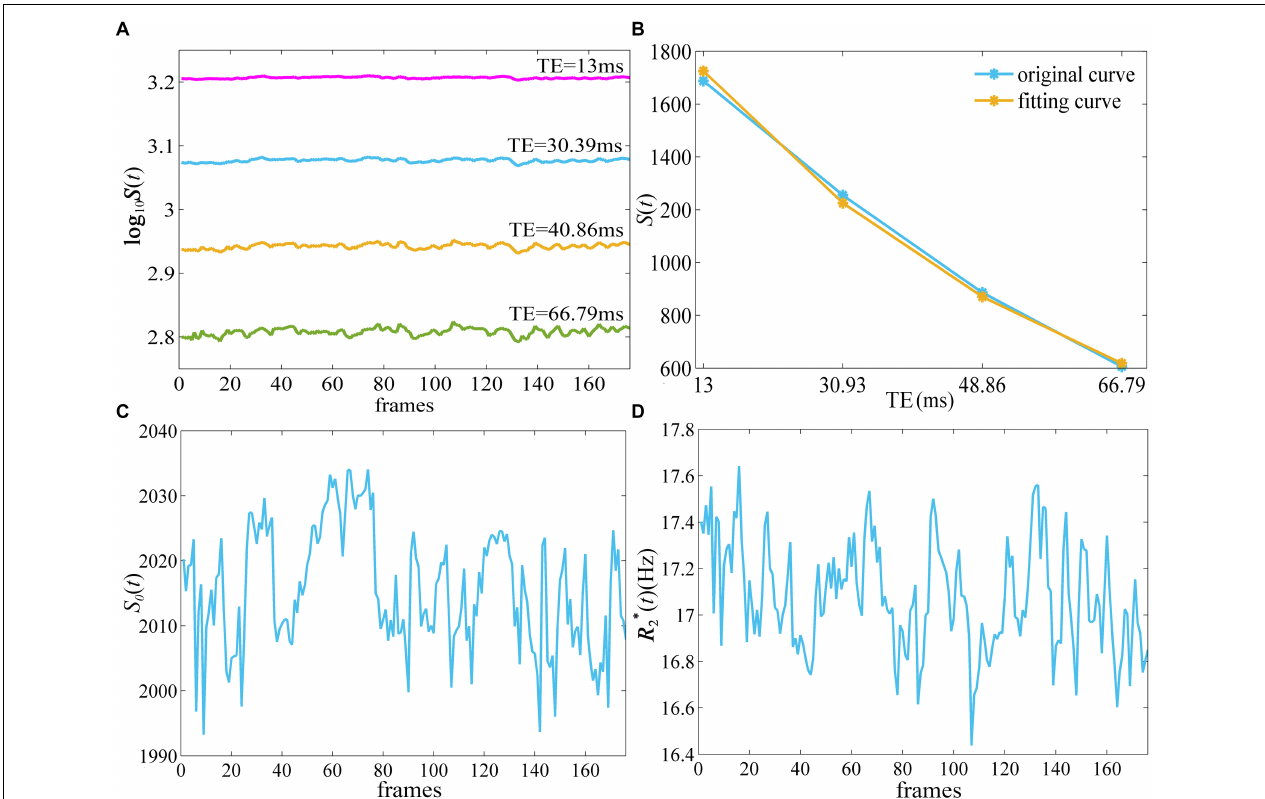
FIGURE 1 | The derivation of quantitative R ∗ 2 ( t ) and S 0 ( t ) from ME-fMRI datasets. By fitting the signal intensities from four TEs (A) to a monoexponential model (B) , quantitative R ∗ 2 ( t ) (D) and S 0 ( t ) (C) were obtained. ME-fMRI, multi-echo fMRI; TEs, echo times.